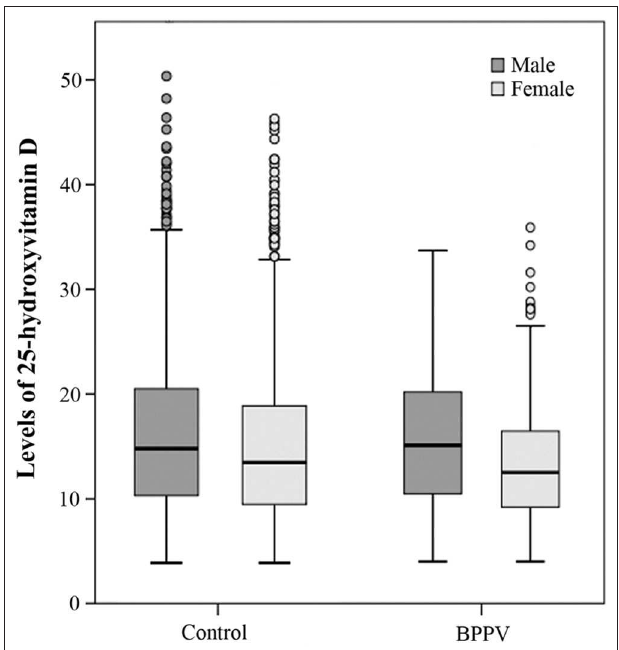
FIGURE 1 | Box blots of 25-hydroxyvitamin D levels in females and males in both the control and BPPV groups. The dark gray box blots indicate male levels of 25(OH)D and the light gray box blots indicate female levels of 25(OH)D. Each box indicates a percentile range of 25–75%, the lines through the boxes represent the medians, and the range lines indicate the upper and lower values that are not classified as statistical outliers. Circles denote 25(OH)D concentrations that are statistical outliers.